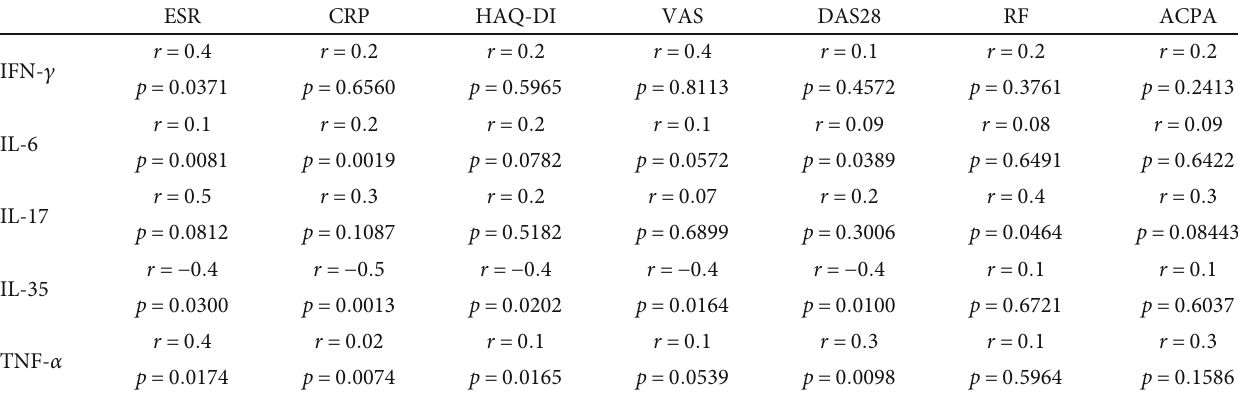
Table 2: Associations between baseline serum levels of cytokines and clinical parameters. ESR CRP HAQ-DI